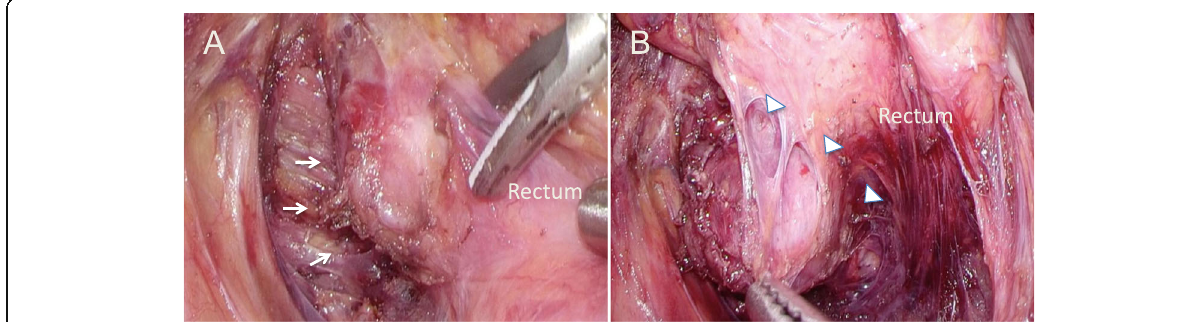
Fig. 4 Intraoperative photos. a En-bloc resection of the tumor from the pelvic muscle fascia (white arrows). b The white arrowheads show the cut surface of the upper edge of the rectum. The tumor had infiltrated into the left posterior wall of the